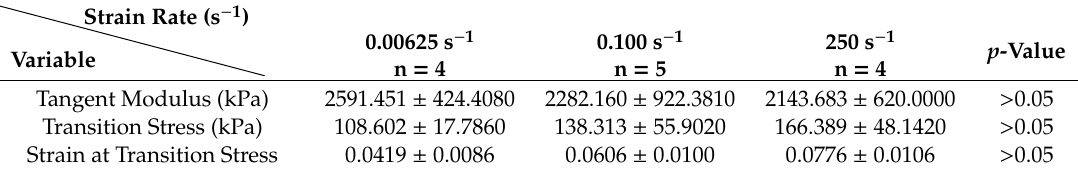
Figure 10. Comparison of experimental quasi-static and high strain rate dry brain (~0% water content m / m) stress–strain behavior (n = 4 (250 s − 1 ), 5 (0.1 s − 1 ), and 4 (0.00625 s − 1 )). Specimens possessed a diameter of 15 mm diameter and a thickness of 5 mm. The error bars represent standard error. Table 6. Statistical Comparison of the tangent modulus, elastic–inelastic transition stress ( σ p / σ t ) and strain at σ p / σ t of the dry brain (~0% m / m water content) at quasi-static and high strain rates. p < 0.05: significantly di ff erent; p > 0.05: significantly indi ff